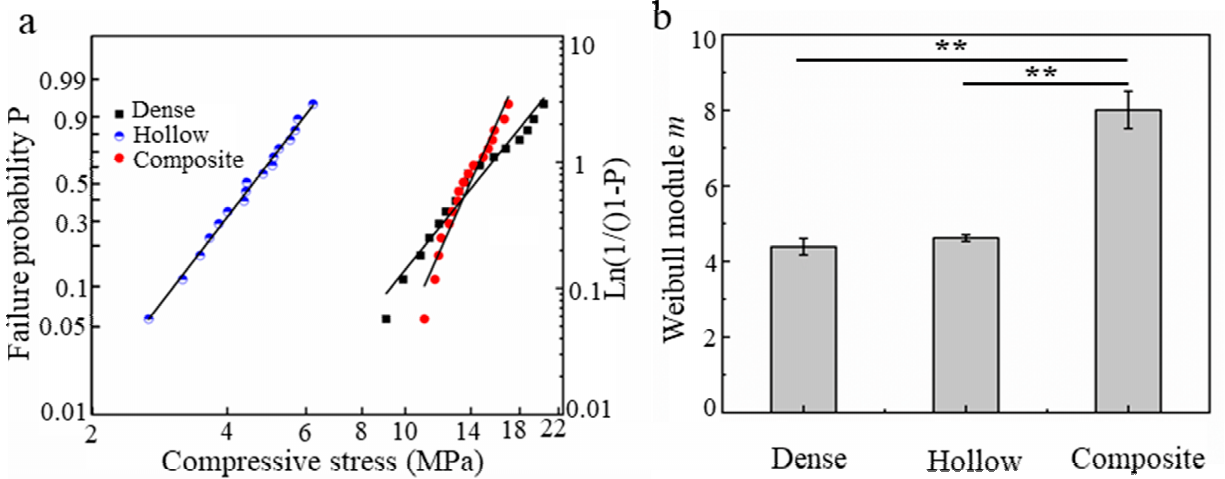
Figure 9. ( a ) Weibull plot of the compressive strength data for the different scaffolds, straight lines are best fits to data using the Weibull probability function ( b ) Weibull modulus, m, for the different scaffolds. (Data presented are the mean ± standard error of the mean, n = 15, ** p < 0.01).